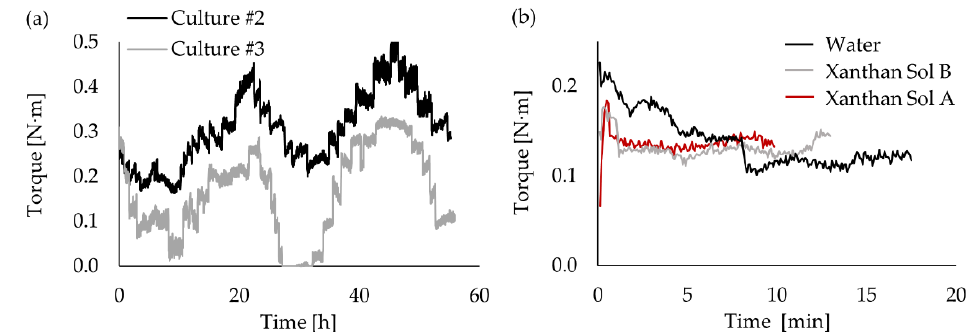
Figure 5. Experimental torque characterization. Torque evolution for the ( a ) microbial alginate batch production and ( b ) abiotic systems.